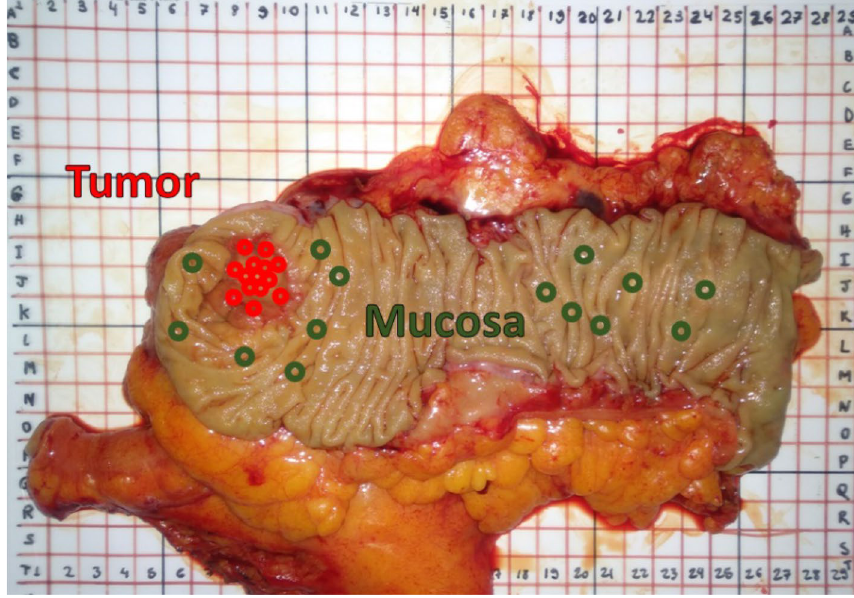
Figure 1. Mucosa and tumor measurement locations on the specimen. Measurements were distributed over a large area in order to obtain a robust dataset containing tissue heterogeneity